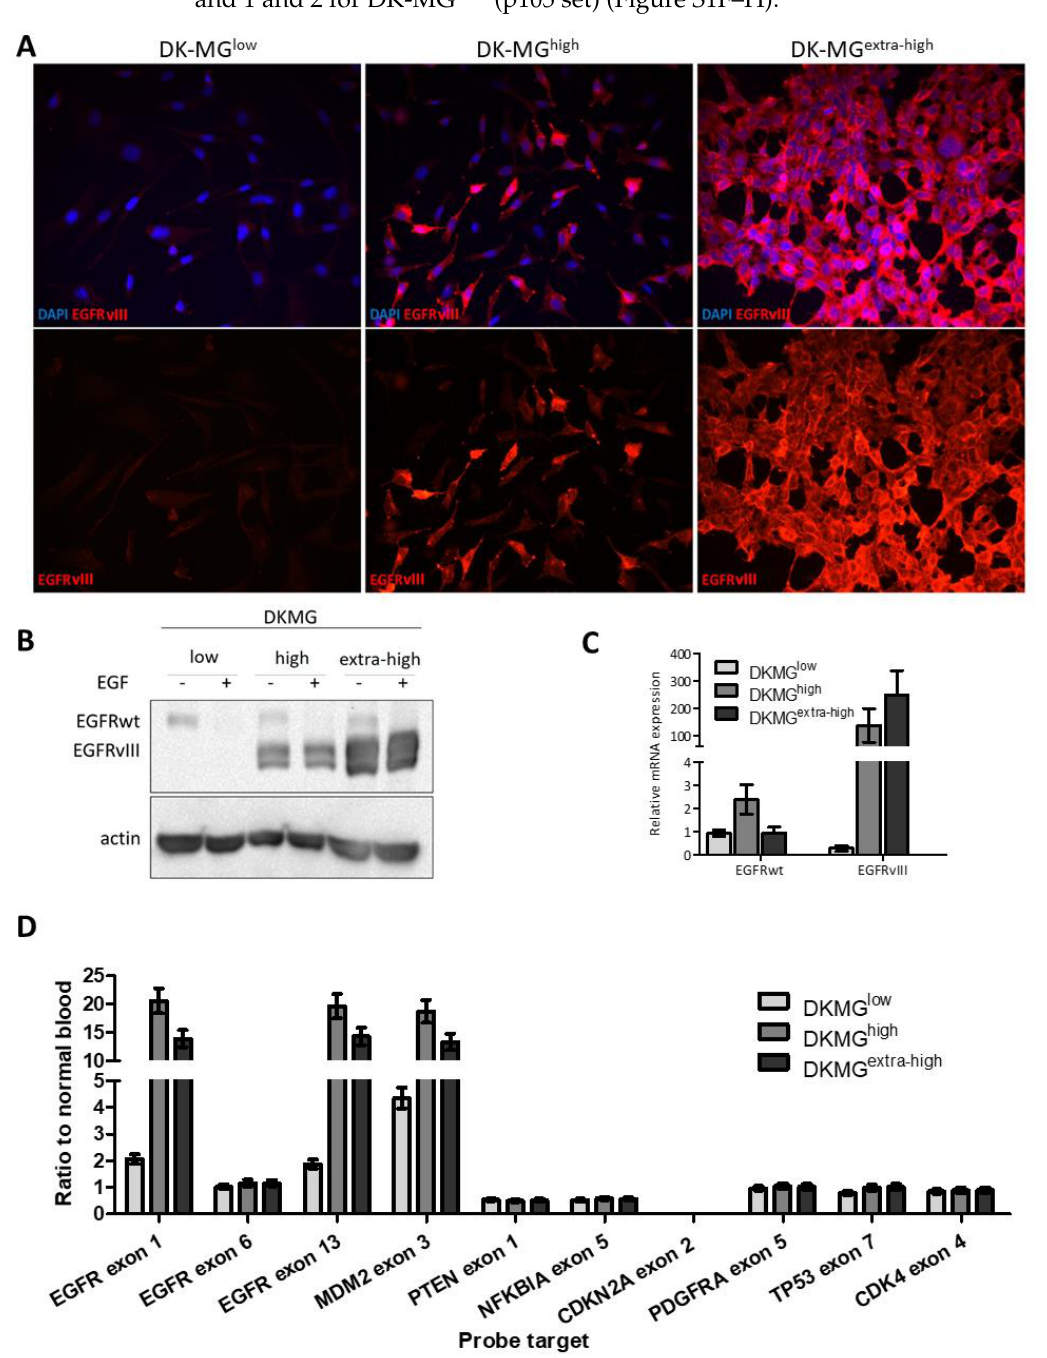
between 16 and 20 (p105 set) for EGFR vIII amplicons and between 12 and 14 for DK-MG high